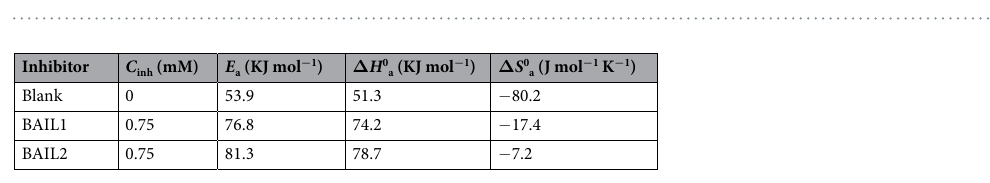
Table 5. Corrosion parameters for carbon steel immersed in 0.5 M HCl solution for 24 h without/with 0.75 mM BAIL1 and 0.75 mM BAIL2 at 298 K, 308 K, 318 K and 328 K obtained from WL measurements.